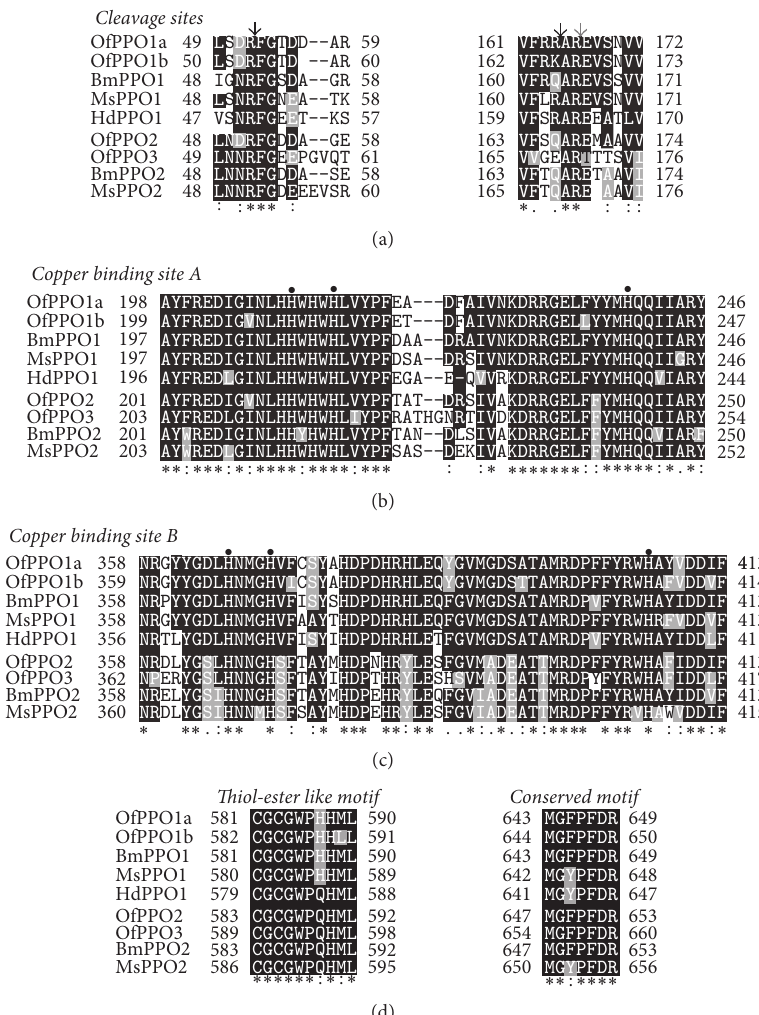
Figure 3: Multiple sequence alignment of conserved regions of insect PPOs. Amino acid sequences of PPOs from O. furnacalis PPO1a (OfPPO1a, KX452359), PPO1b (OfPPO1b, KX437622), PPO2 (OfPPO2, ABC59699), PPO3 (OfPPO3, KX437621), B. mori PPO1 (BmPPO1, AAG09304), PPO2 (BmPPO2, D49371), M. sexta PPO1 (MsPPO1, AF003253), PPO2 (MsPPO2, AAC37243), and H. diomphalia PPO1 (HdPPO1, AB079665) were aligned using the Clustal W. Alignments of potential cleavage sites (a), two independent copper binding sites (b and c), and two C-terminal conserved motifs (d) are shown. Numbers on both ends of each peptide represented amino acid residue numbers of the respective proteins. Amino acid residues shared by four or more proteins are shown by white letters on black background, while conservative amino acid substitutions are on grey background. Asterisks on the bottom of the alignment denoted amino acids shared by all proteins while small dots indicate conservatively substituted amino acids. The arrows in (a) indicate the potential proteolytic cleavage sites for PPO activation. Three large dots in (b) and (c) indicate the histidine residues coordinated with the copper